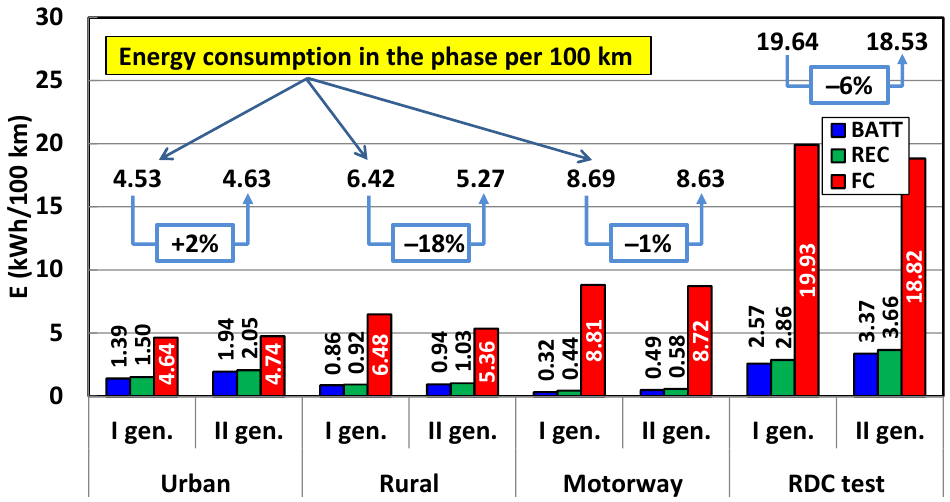
Figure 16. Energy consumption values for both generations of Toyota Mirai drive in individual test drive sections as well as throughout the whole test (the height of bars corresponds to energy from the battery, energy recovered and energy from the fuel cell). The analysis of the total energy consumption (E FC + E BATT − E REG ) indicates that a higher consumption for the new generation drive only occurred in the first (urban) driving section. Each subsequent section resulted in lower energy consumption. The greatest differences were recorded in the rural section (due to significant differences in fuel cell energy consumption). The total difference in the RDC test was 6% in favor of the second- generation